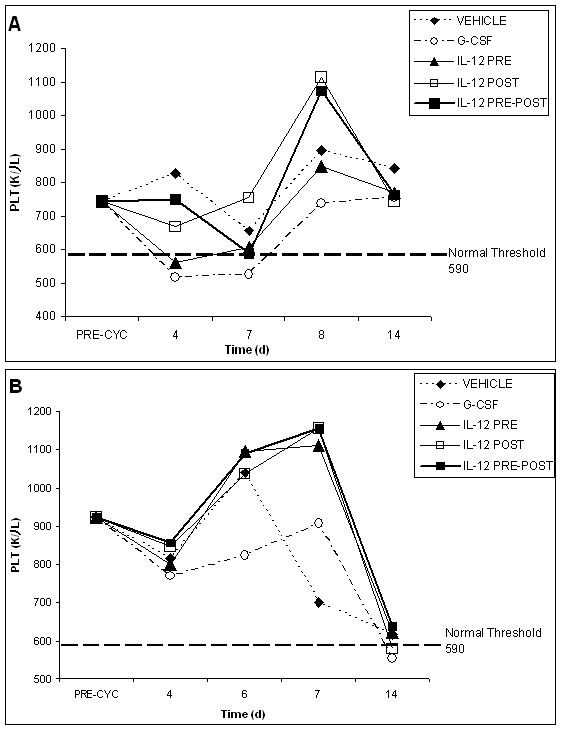
Platelet recovery profiles for vehicle, G-CSF, IL-12 pre-only, IL-12 post-only and IL-12 pre-post treatment groups following chemotherapy . Platelet recovery profiles are shown for the EL4 tumor model in (A) and the Lewis lung cancer model in (B). Pre-chemotherapy blood values reflect an average of all animals in both groups (80 mice) before cyclophosphamide and tumor inoculation. The normal threshold value for murine platelet counts is indicated. EL4 mice received a cyclophosphamide dose of 250 mg/kg and the LL mice received a cyclophosphamide dose of 225 mg/kg. IL-12 treated mice received a total dose of 50 ng (pre-only) and 150 ng (post-only and pre-post (pre-post dose was split 50 ng before and 100 ng after cyclophosphamide)), whereas G-CSF treated mice received a total dose 1.5 μg.